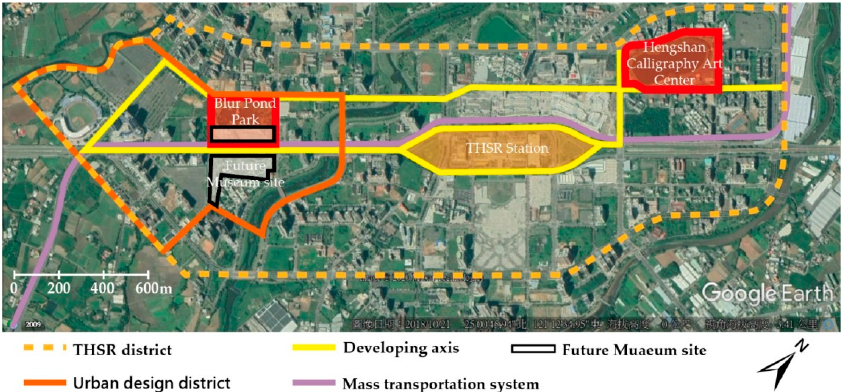
Figure 16. Two ponds, museum (2024), rails, and Taiwan High Speed Rail (THSR) station.